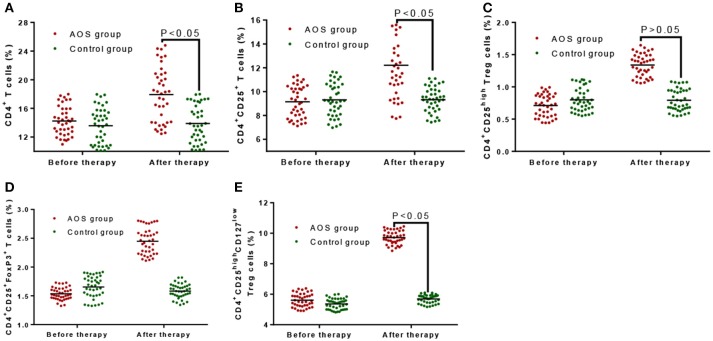
The effects of AOS on the contents of T cells in the children with allergy asthma. (A) The effects of AOS on the contents of gated CD4+ T cells in the children with allergy asthma. (B) The effects of AOS on the contents of CD4+CD25+ T cells in the children with allergy asthma. (C) The effects of AOS on the contents of CD4+CD25high Treg cells in the children with allergy asthma. (D) The effects of AOS on the contents of CD4+CD25+FoxP3 Treg cells in the children with allergy asthma. (E) The effects of AOS on the contents of CD4+CD25highCD127low Treg cells in the children with allergy asthma. n = 40 for each group. The statistical difference was significant for P < 0.05.